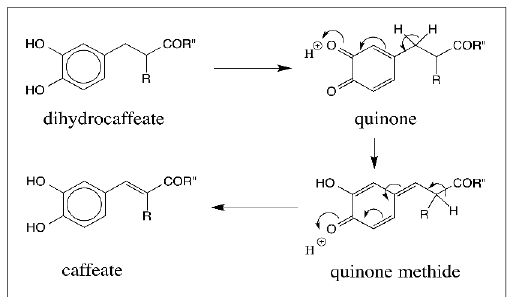
Figure 16. Oxidative transformation of dihydrocaffeate derivatives. Dihydrocaffeate derivatives (R” = NHCH 3 or OCH 3 ) upon oxidation produce the unstable quinones that exhibit rapid tautomerization to quinone methides. These quinone methides suffer another nonenzymatic isomerization producing more stable caffeic acid derivatives. This reaction also occurs with N -acetyldopa esters (R = NHCOCH 3 ; R” = OCH 3 or OCH 2 CH 3 ).